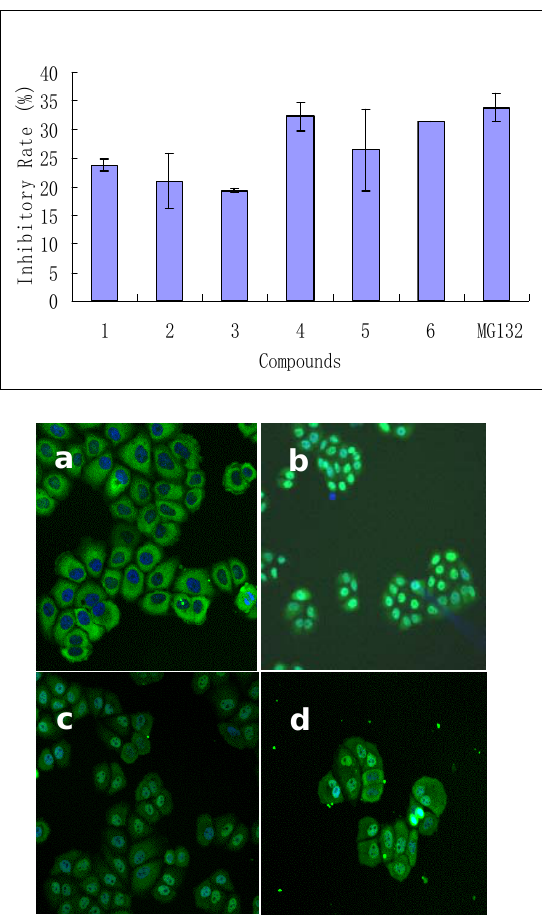
Figure 2 . Inhibitory effect of 1 - 6 on TNF- α - induced NF- κ B activation in HeLa cells. A. Percentage of inhibitory rate of NF- κ B activation induced by 50 ng/ml of TNF- α in